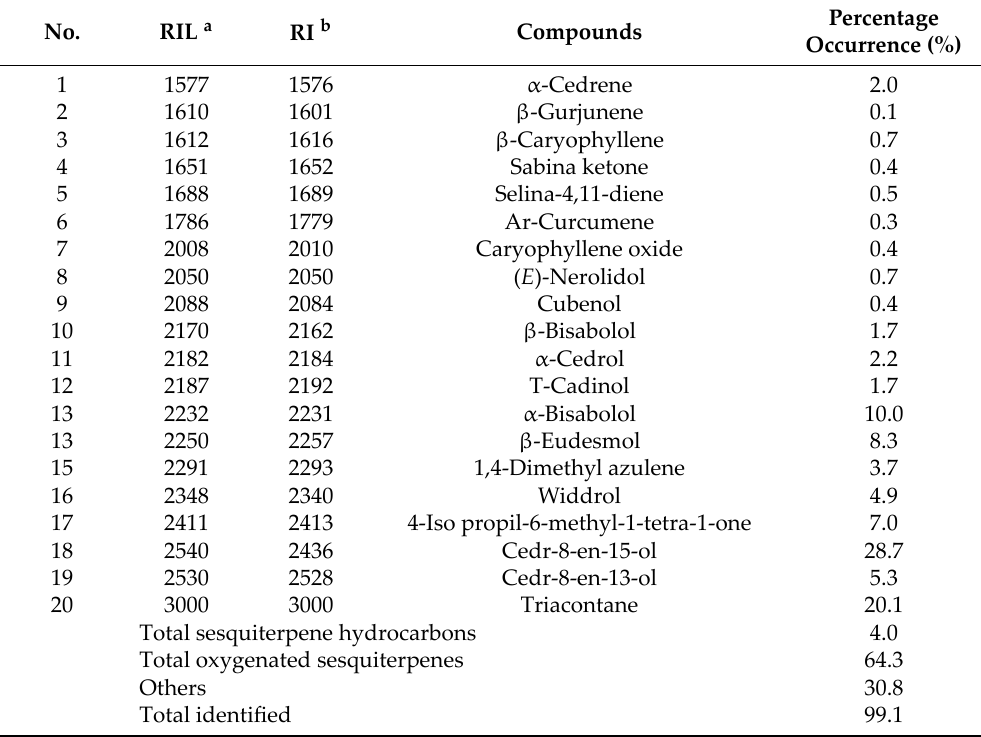
Table 2. Chemical composition of essential oil from root of Chrysopogon nigritanus .